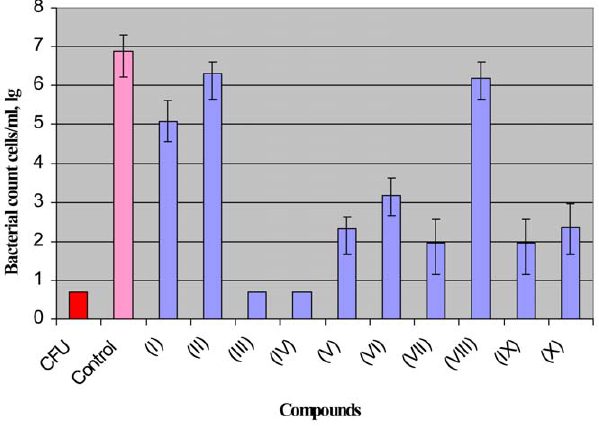
Figure 3. Influence of NPT compounds on resuscitation of M. smegmatis ‘‘non-culturable’’ cells. Resuscitation was performed by the MPN assay (for details see ‘‘Materials and methods’’). Inhibitors were added at 1 m g/ml to some wells. Plates were incubated for 2 weeks at 37 u C with shaking, 100 rpm. CFU of the culture before resuscitation was , 5 cells/ml. Bars represent (95%) confidence limits for MPN assay. This experiment was repeated six times using different starved cultures with similar results. One typical experiment is shown.